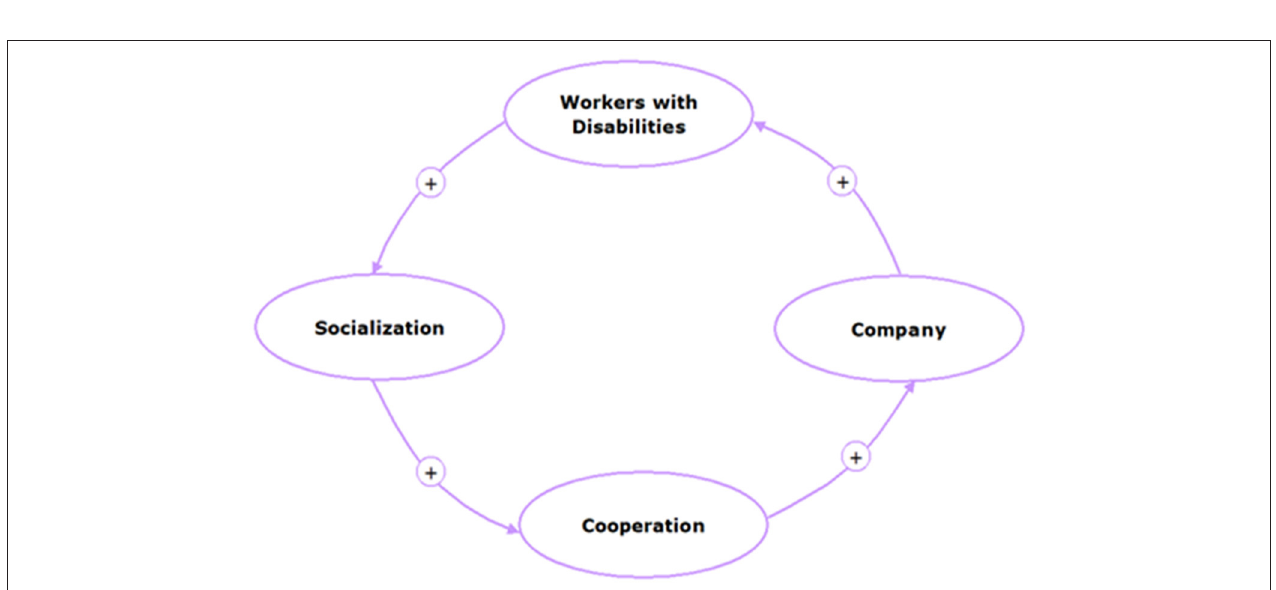
FIGURE 3 | Loop 1: Socialization → cooperation → company → PwD → workers → socialization. The “ + ” symbol indicates unidirectional causality, and the “ − ” symbol in the arrow represents the opposite directions of causality.